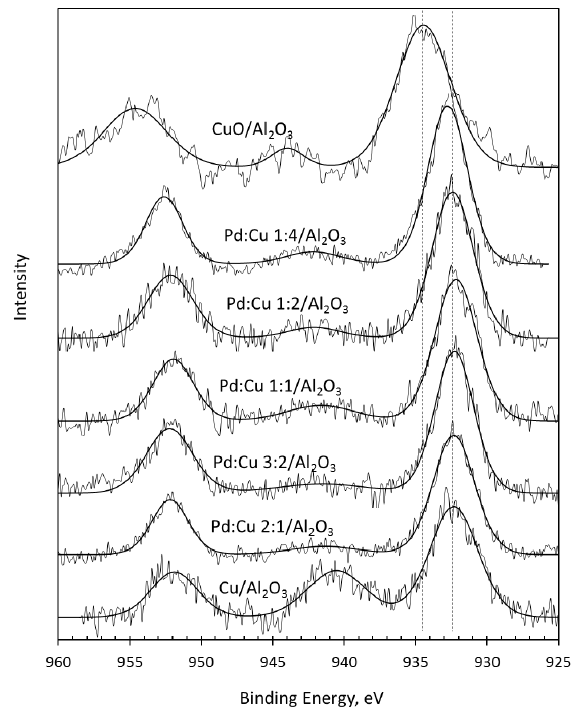
Figure 5. X ‐ ray photoelectron spectra of the Cu 2p of each catalyst.